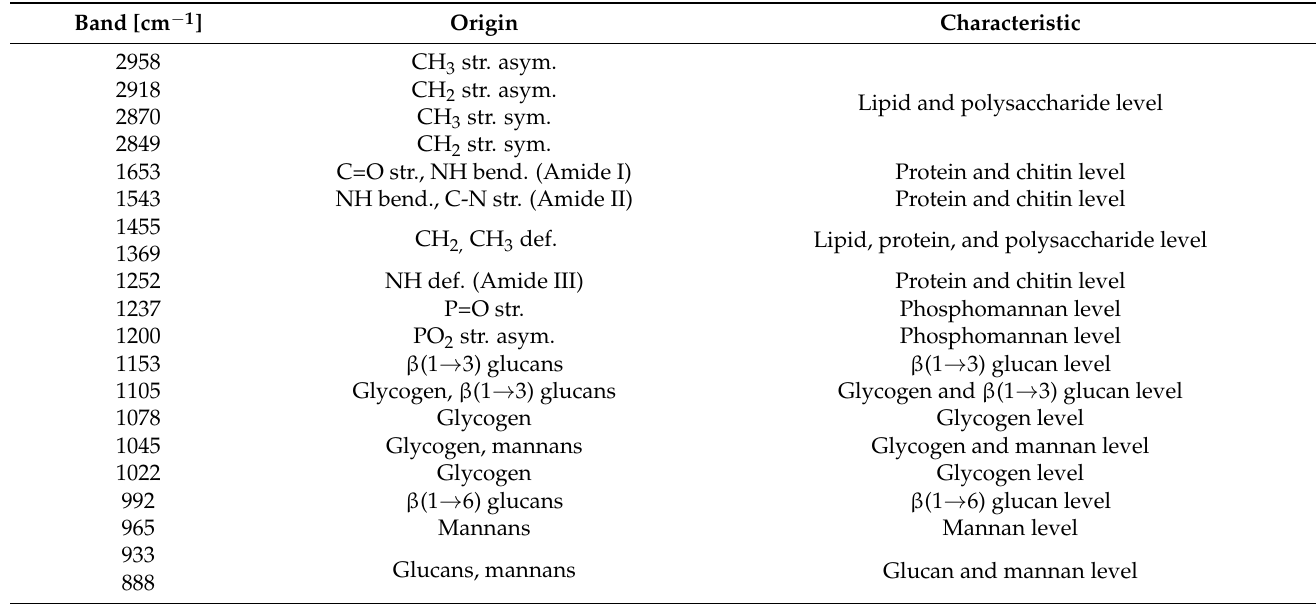
Table 5. Identification of ATR-FTIR bands in C. albicans spectra; str.—stretching, asym.—asymmetric, sym.—symmetric, def.—deformation, bend.—bending vibratiosns